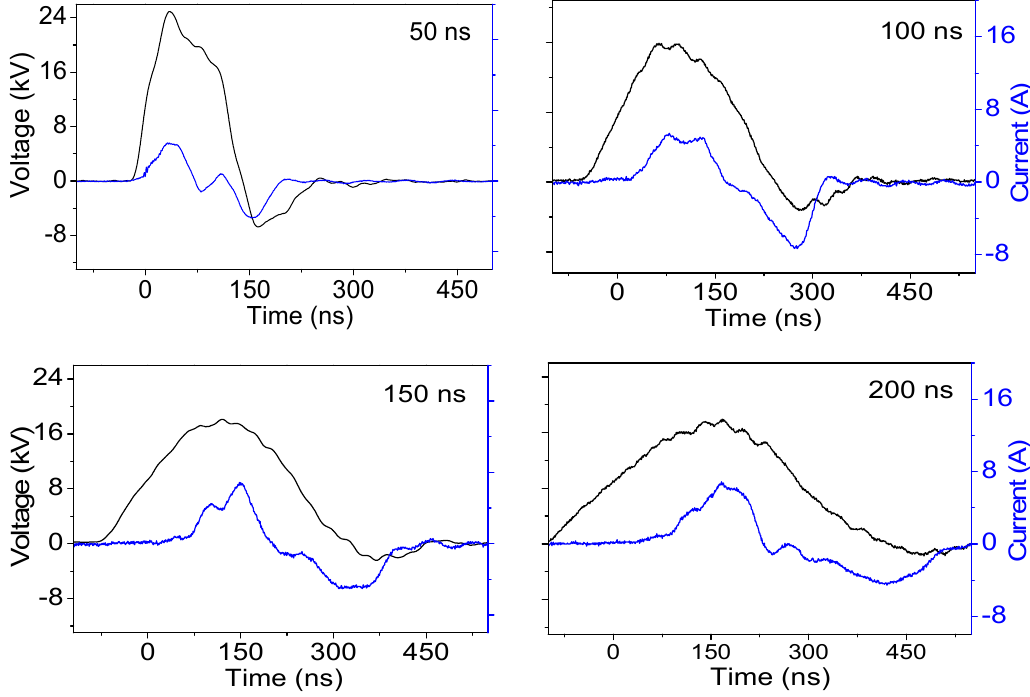
Figure 4. Waveforms of the applied voltages and discharge currents under different pulse rising and falling times.